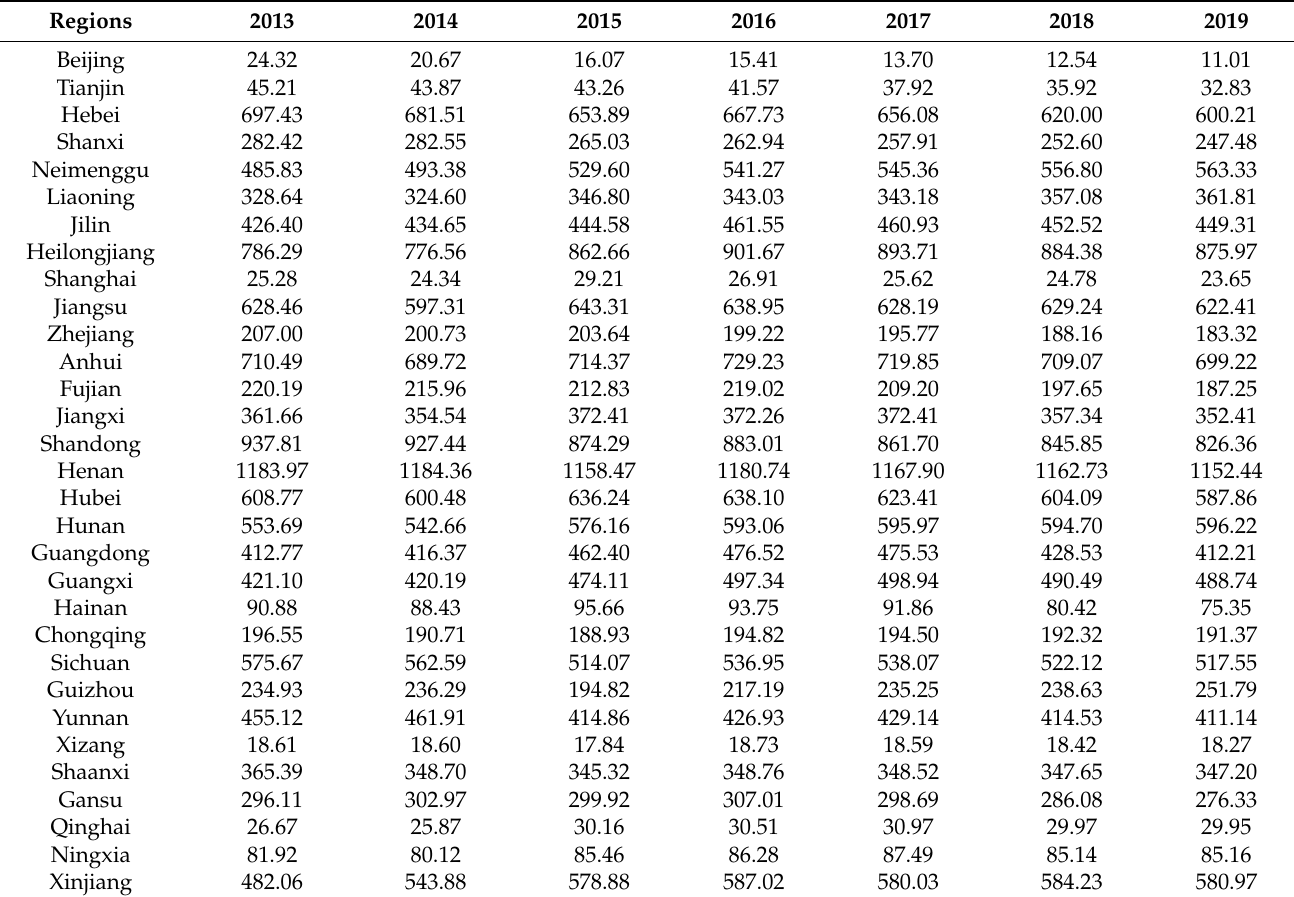
Table A3. Carbon emissions (10 4 t) from the planting industry in rural China from 1998–2019 (continued Table A2).